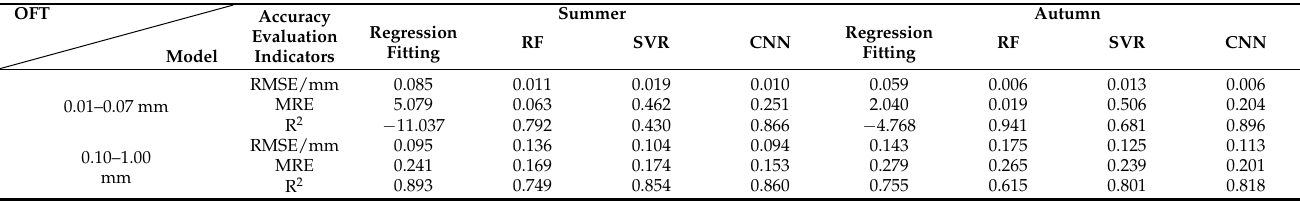
Table 2. Model inversion accuracy